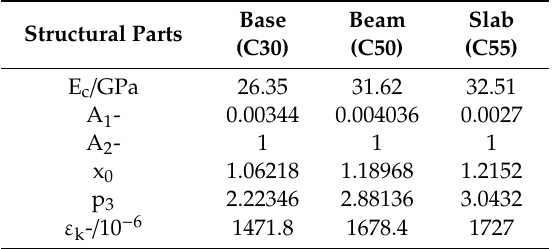
Table 3. Parameters related to the uniaxial compressive constitutive model of concrete